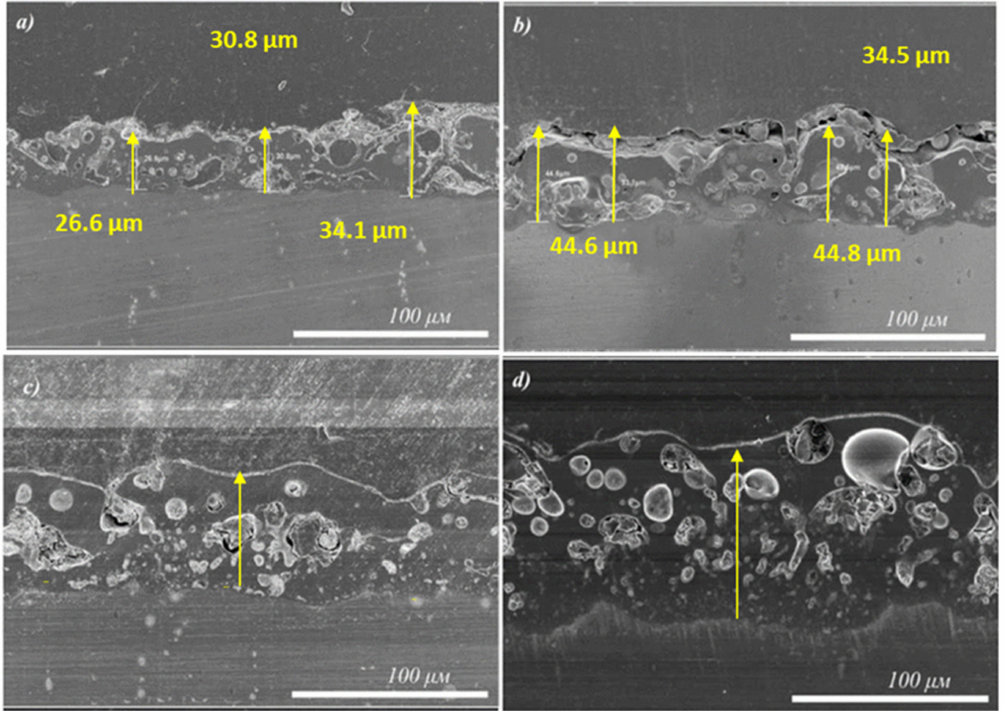
Figure 3. Cross-sectional SEM images of the PEO coatings formed under different current densities